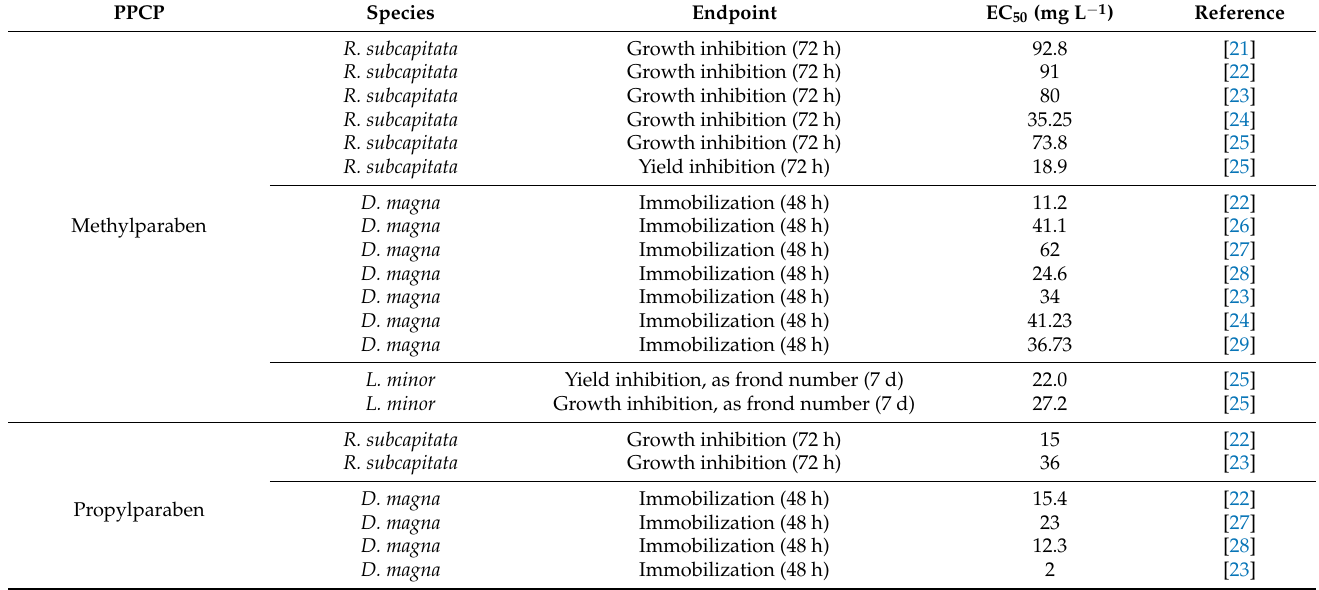
Table 2. Summary of the reference median effective concentrations (EC 50 ) reported in the literature for each of the tested PPCPs, estimated on the basis of toxicity tests following similar protocols to those carried out in the present study with R. subcapitata (formerly known as Pseudokirchneriella subcapitata ), D. magna , L. minor , and L. sativum